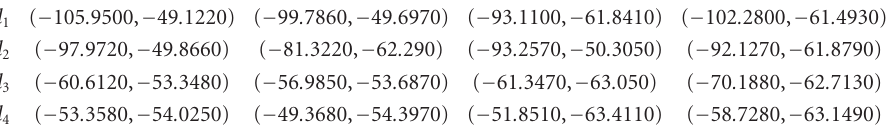
Table 4.1. The vertexes’ coordinates of d 1 , d 2 , d 3 , d 4